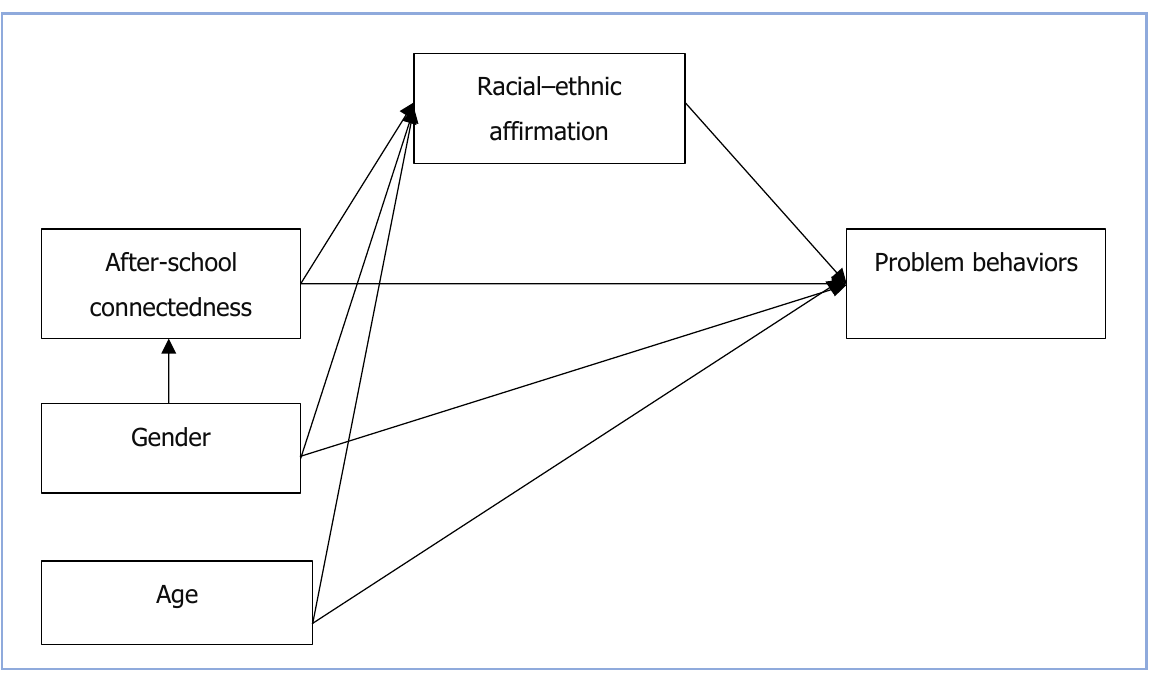
Figure 1. Conceptual